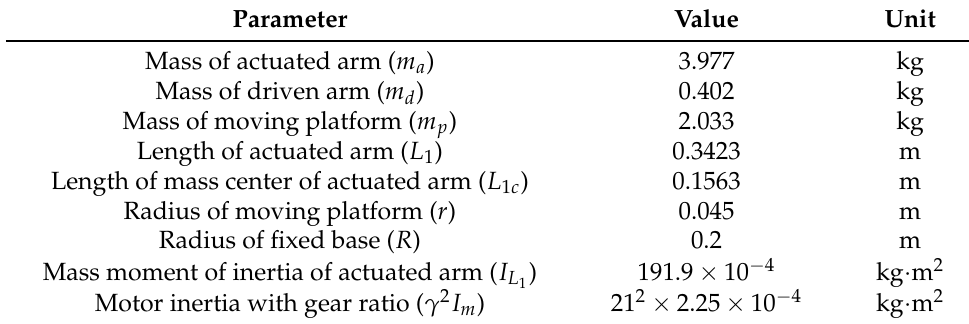
Table 1. Parameter values provided by the manufacturer for the dynamic analytic model in